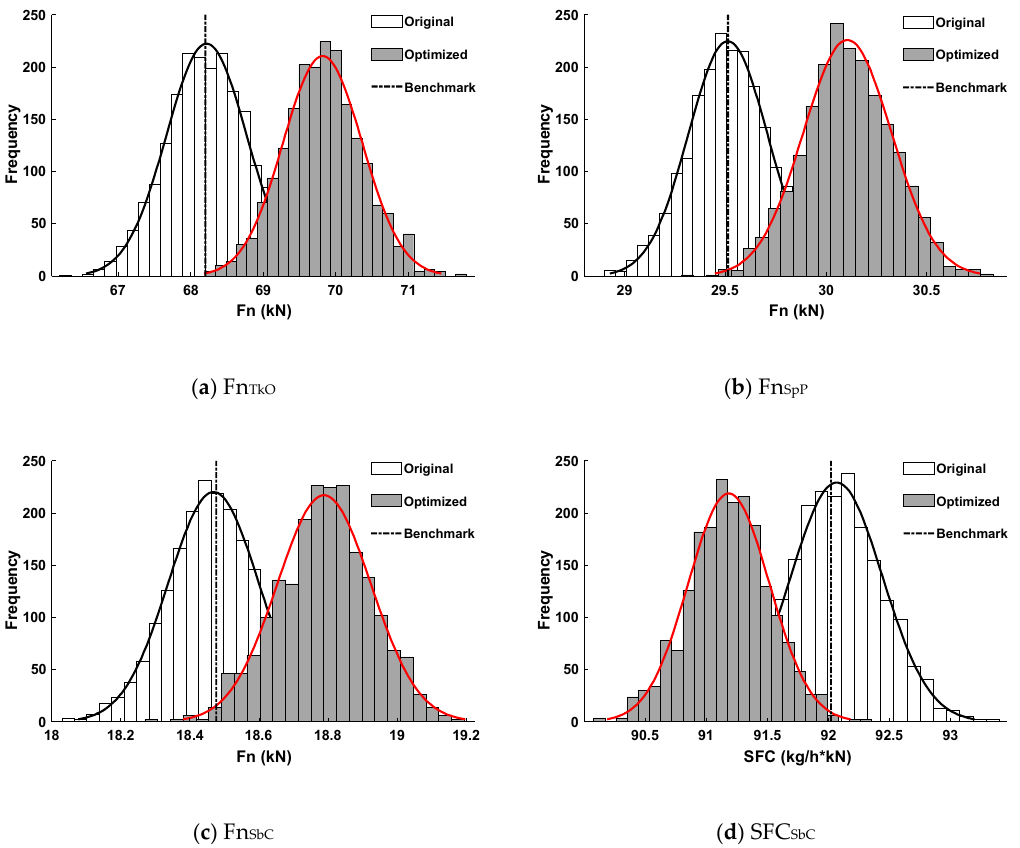
Figure 11. Aeroengine overall performance frequency histogram.